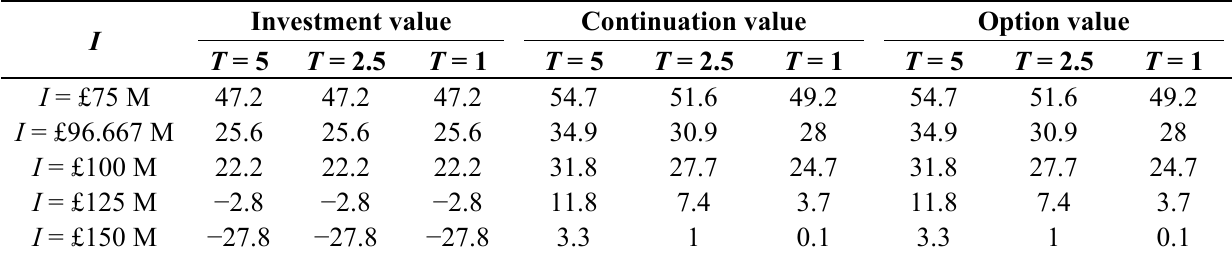
Table 18. Option value (£M) as a function of the option’s maturity T (years).